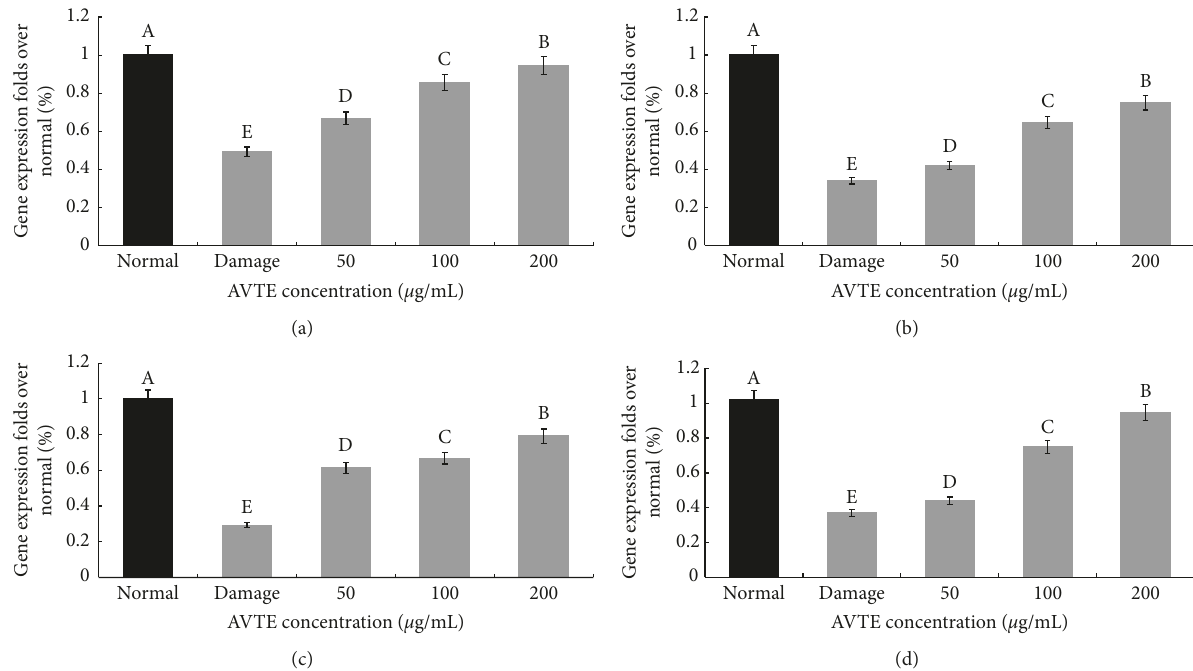
Figure 7: Effects of AVTE on antioxidant-related GSH-Px, GSH, SOD, and CAT gene expression in 293T cells. (a) GSH-Px; (b) GSH; (c) SOD; and (d) CAT. Fold ratio of GSH-Px, GSH, SOD, and CAT mRNA expression over the normal. The calculation formula is as follows: gene expression/GAPDH × normal numerical value (normal fold ratio: 1). A–E Mean values with different letters in the same bar graph are significantly different ( P < 0 . 05) according to Duncan’s multiple range test.